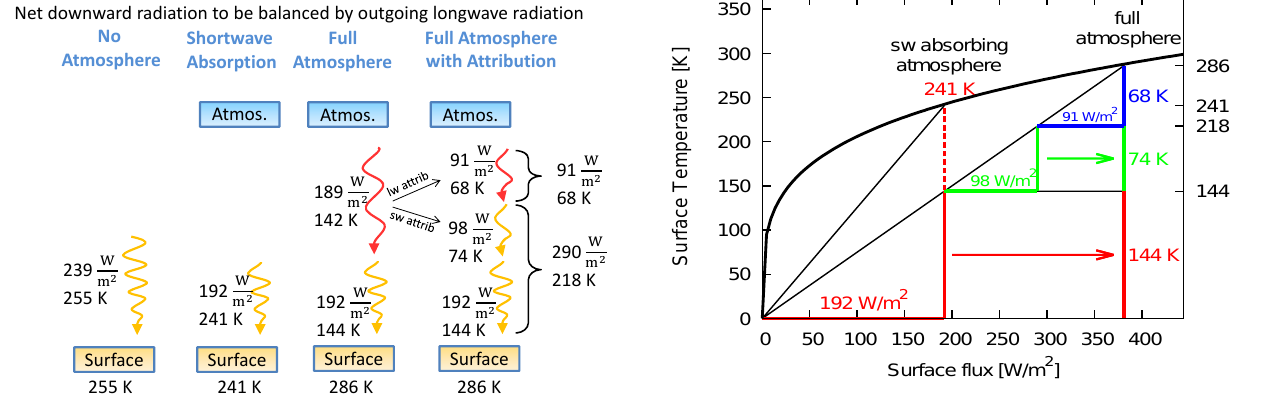
Fig. 6. Surface temperature (K) as a function of the surface flux (sum of net sw and downward lw) (black line Wm − 2 ) and attribu- tion of temperature contributions to fluxes (colour code as in Fig. 2: red: sw contribution; green: background greenhouse gases; and blue background: CO 2 ). See also Fig.